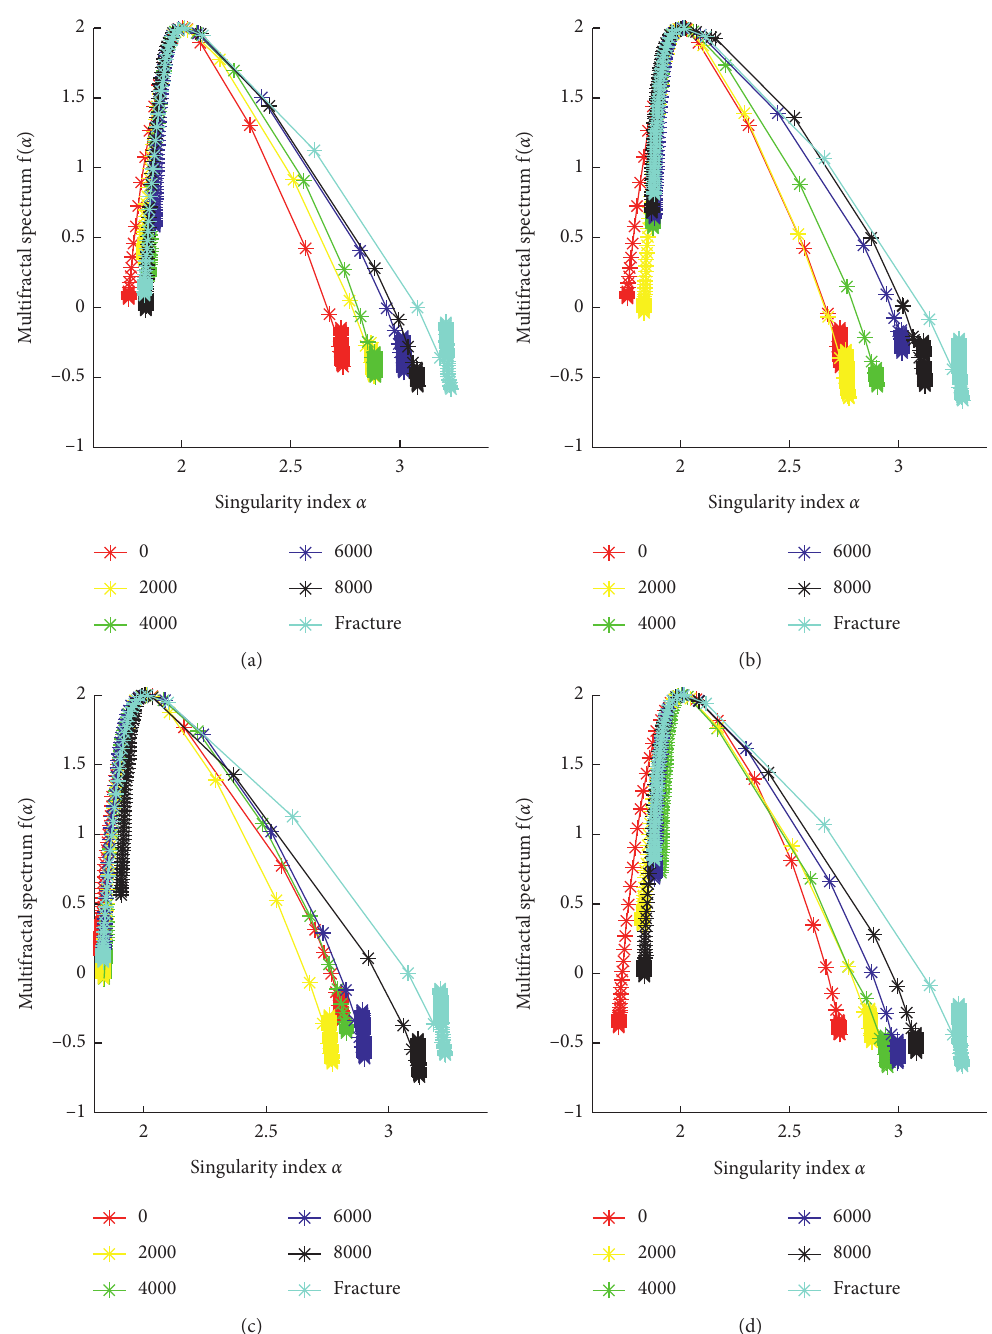
Figure 8: The surface multifractal spectrum of the metal fatigue process. (a) Specimen no. 1. (b) Specimen no. 2. (c) Specimen no. 3. (d) Specimen no.